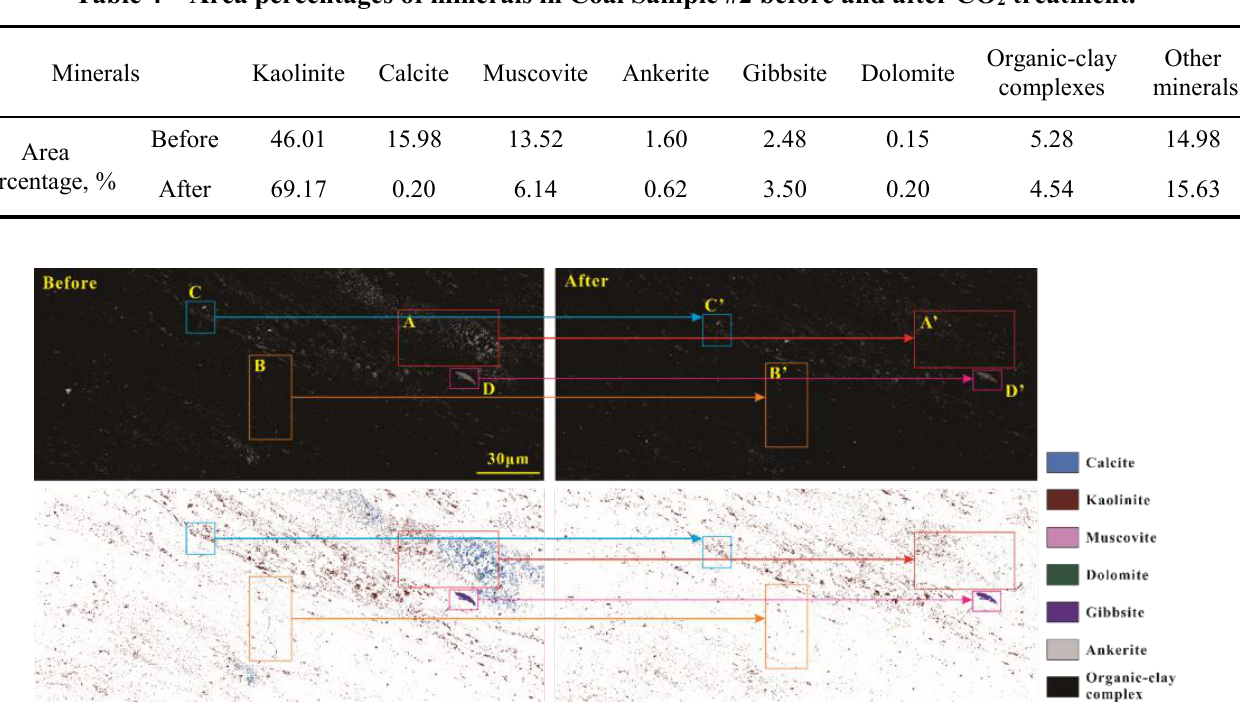
Figure 10—The FESEM and EDS images of Coal Sample #2 before and after CO 2